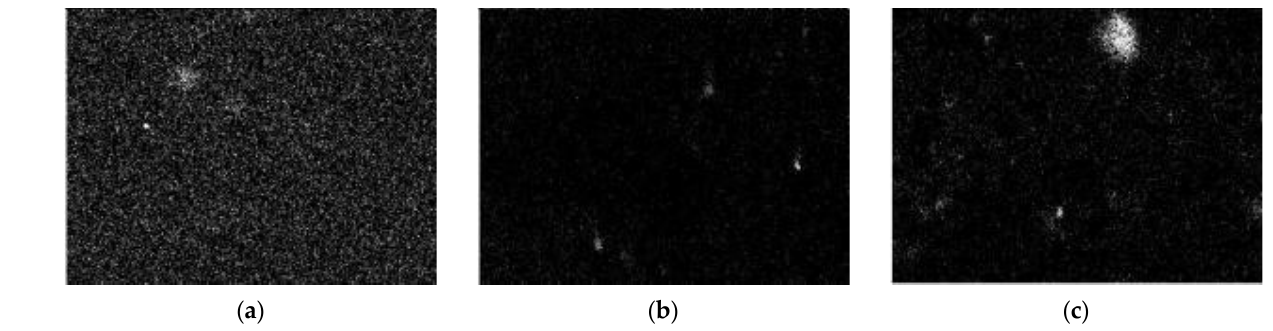
Figure 13. Fe distribution mapping data in experimental plants: ( a ) Root; ( b ) stem; ( c ) seeds.